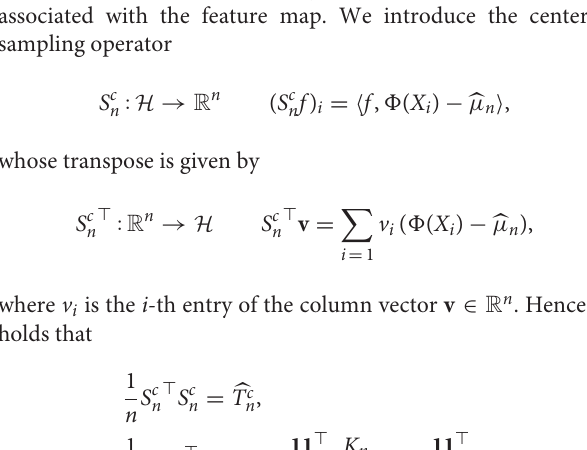
where Tr( A ) is the trace, A ⊤ is the transpose and